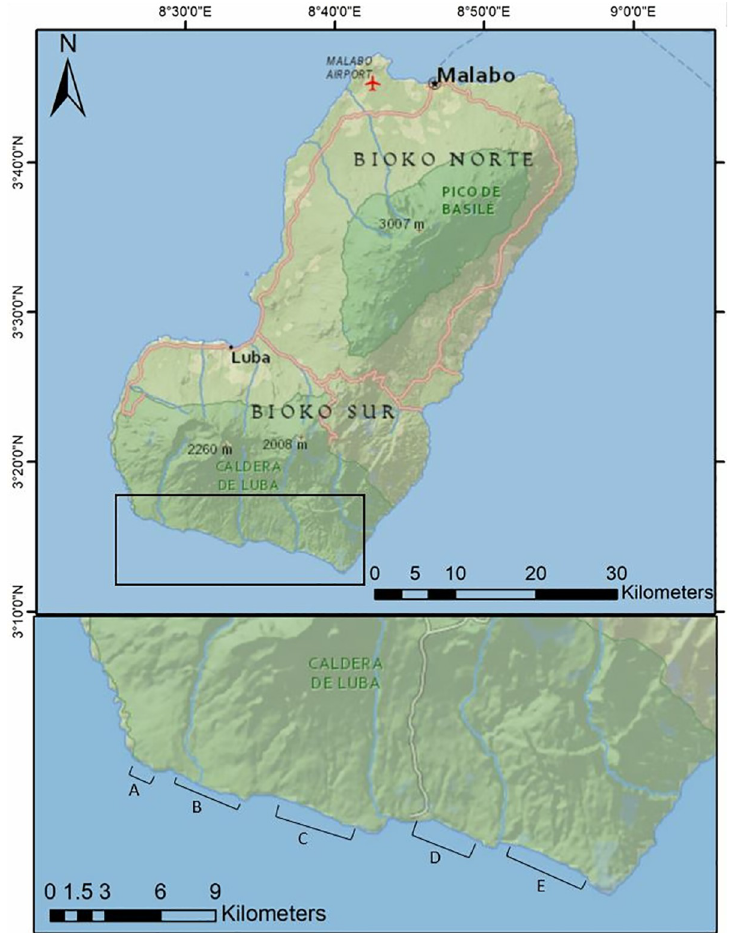
Fig 1. Map of the sea turtle nesting beaches on Bioko Island, Equatorial Guinea. Gran Caldera Southern Highlands Scientific Reserve is shown in dark green covering the southern third of the island. Insert shows the five nesting beaches (A-E) in relation to the nearest village, Ureca. Satellite transmitters were attached to green turtles nesting on Beach C, at the end of the nesting season in January-February 2018. Service Layer Credits: National Geographic, Esri, Garmin, HERE, UNEP-WCMC, USGS, NASA, ESA, METI, NRCAN, GEBCO, NOAA, increment P